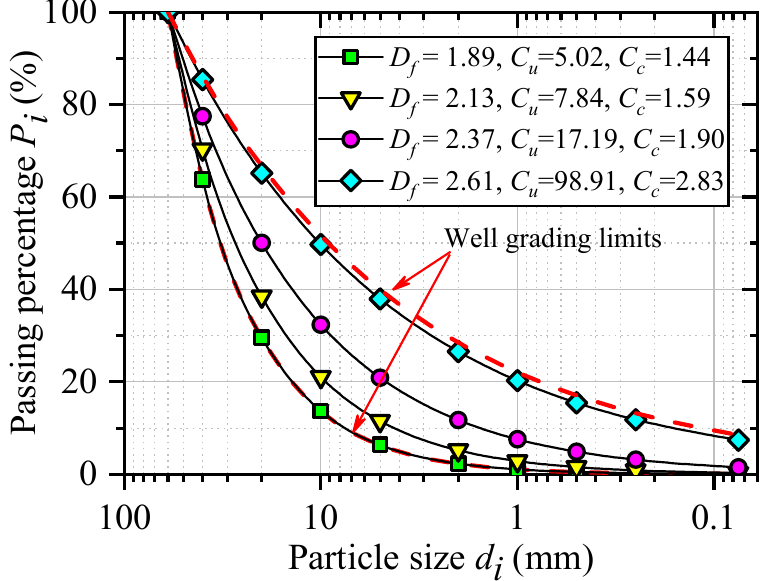
Figure 4. Particle size distribution of the tested materials.